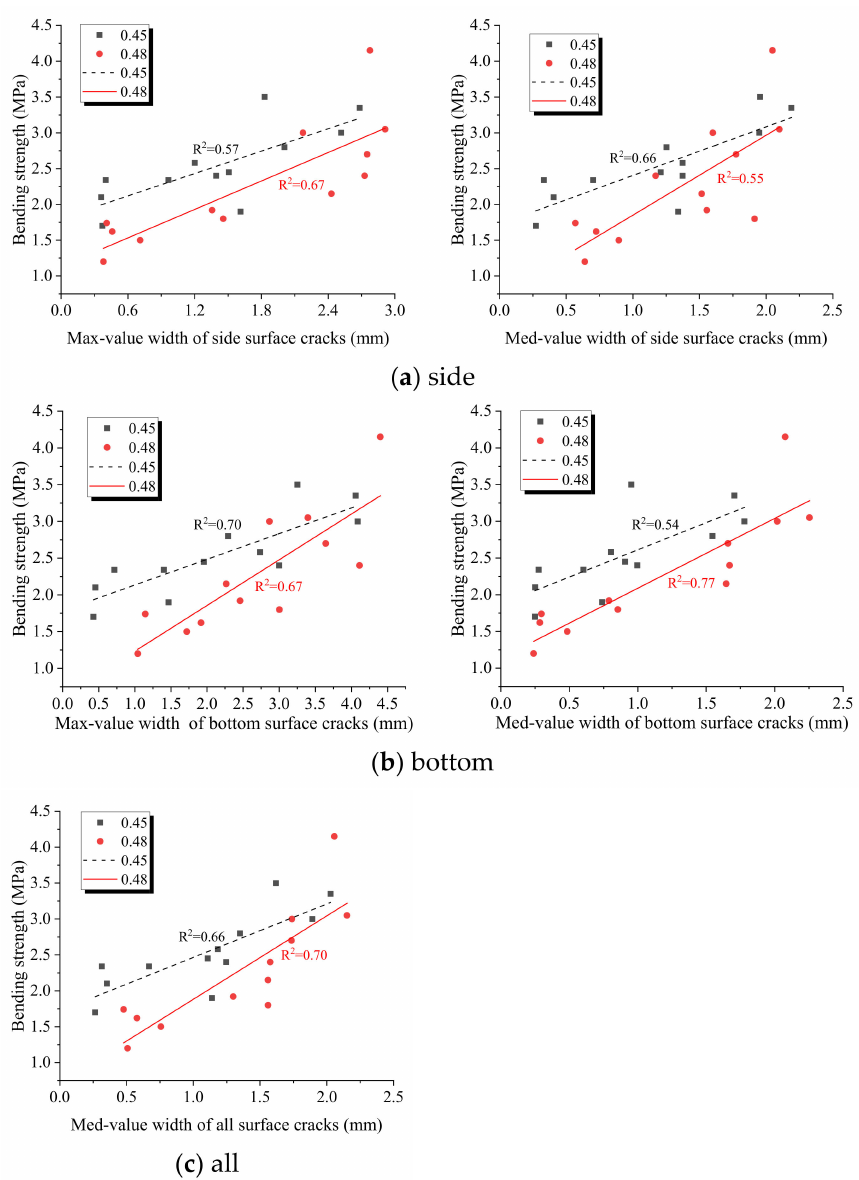
Figure 13. Relationship between bending strength and crack width.